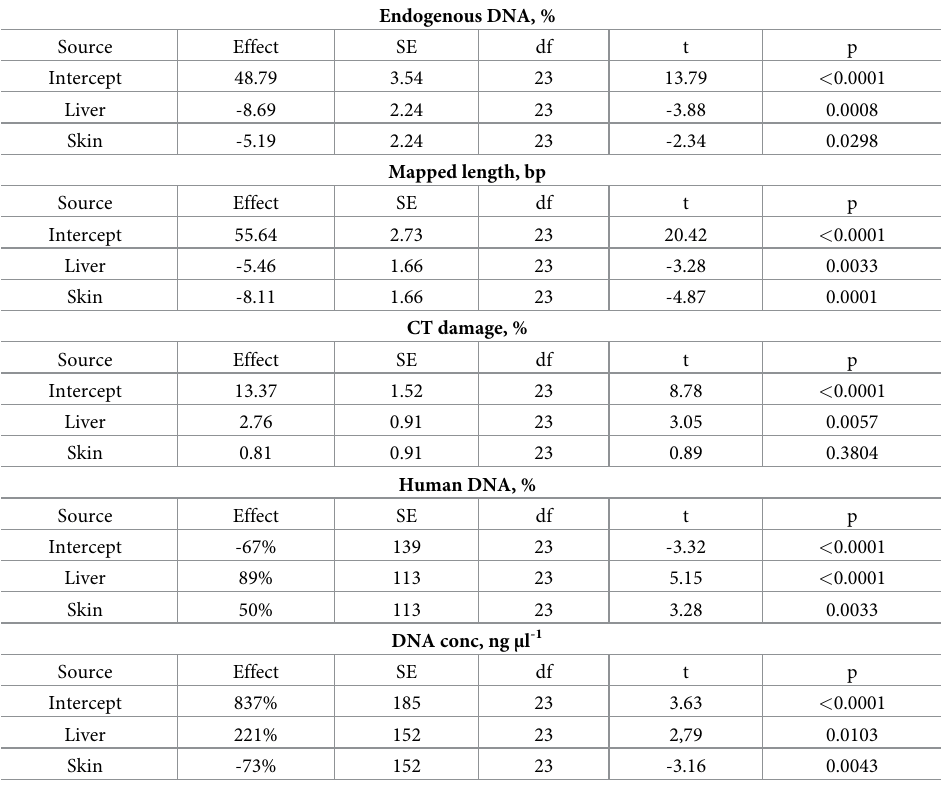
Table 3. Linear mixed effects model.